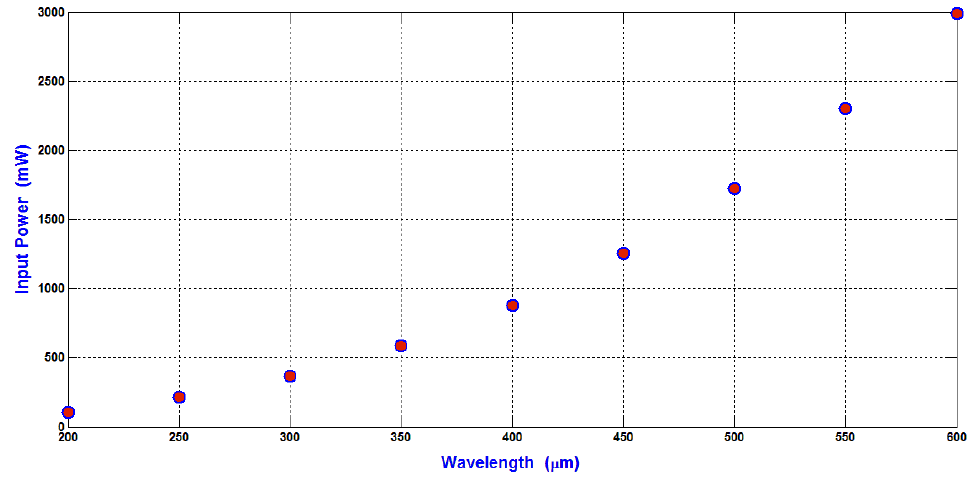
Figure 7. The relation between the minimum input power required to shift the WBCs to the side wall of the main SSAW microchannel at the end of the working time of SAW and the wavelength.